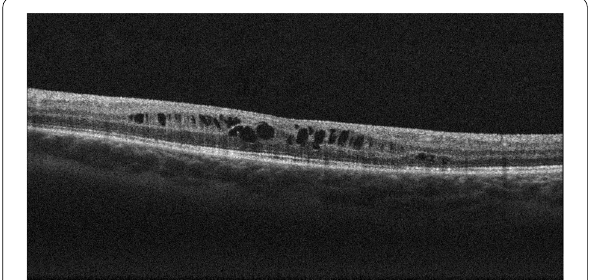
Fig. 2 Optical coherence tomography shows cystoid macular edema